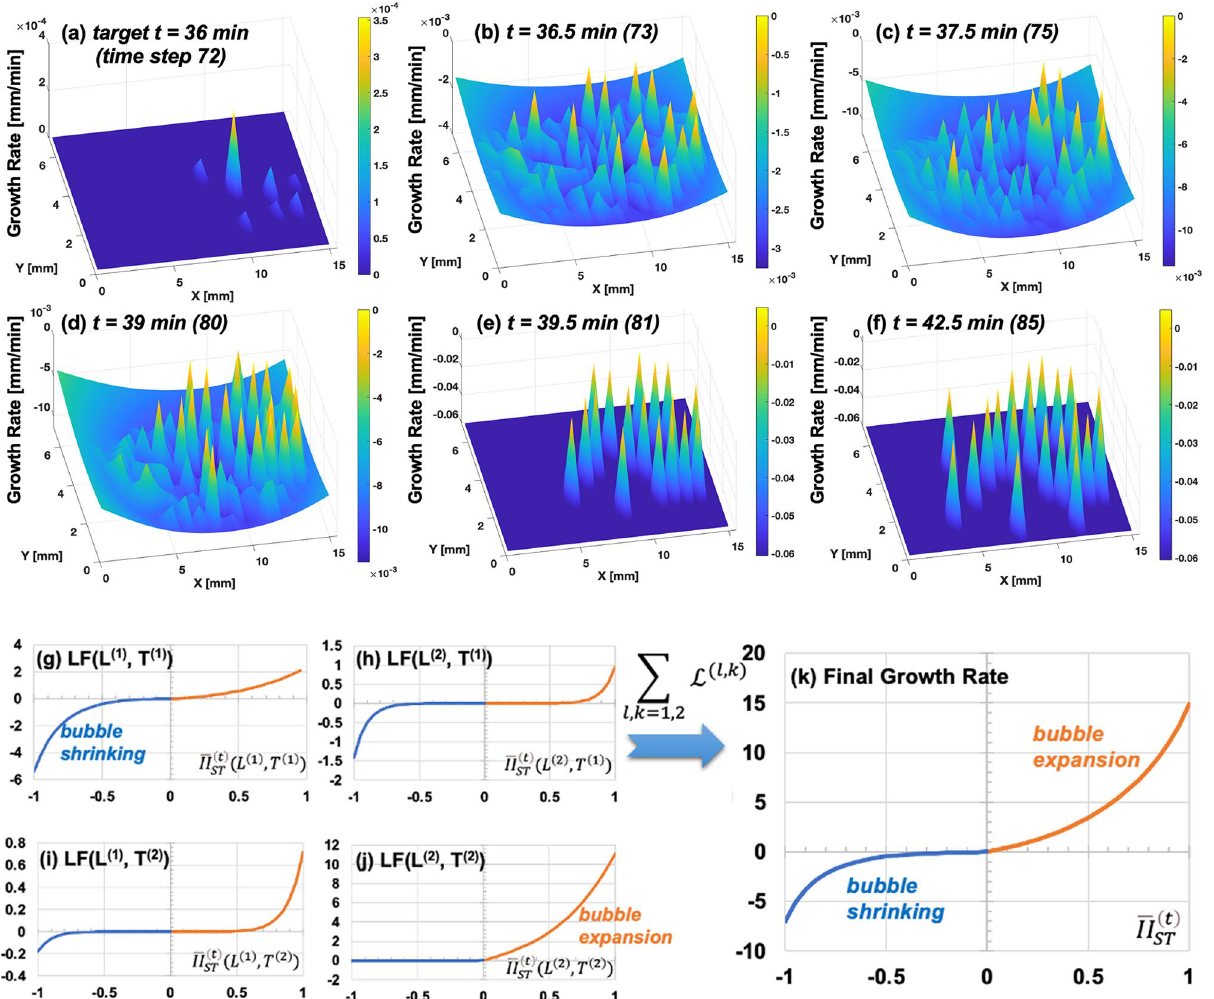
Figure 6. Evolution of the GPRL-identified bubble growth rate at each target 30 min later: ( a ) First GPRL- generated growth rate at target time 36 min using initial four observations ( t = 0, 2, 4, 6 min) showing weak a few peaks; ( b ) Second GPRL-generated growth rate at target 36.5 min using four observations ( t = 0.5, 2.5, 4.5, 6.5 min) revealing widespread bubble shrinking rates (rate < 0); ( c , d ) GPRL-generated growth rate at target 37.5 and 39 min both resembling the widespread bubble shrinking rates as ( b ); ( e – f ) Coexistence of bubble growth (rate > 0) and shrinking (rate < 0) revealed by GPRL. ( g – k ) Best-so-far bubble growth rate rules identified by GPRL with the 30-min prediction of elongated bubble array: ( g – j ) Decomposed four link functions (LFs) with different spatial and temporal influence ranges. The spatial ranges are [mm] and temporal ranges are [minutes]; ( k ) final bubble growth rate showing asymmetric growth rates in expansion and shrinking